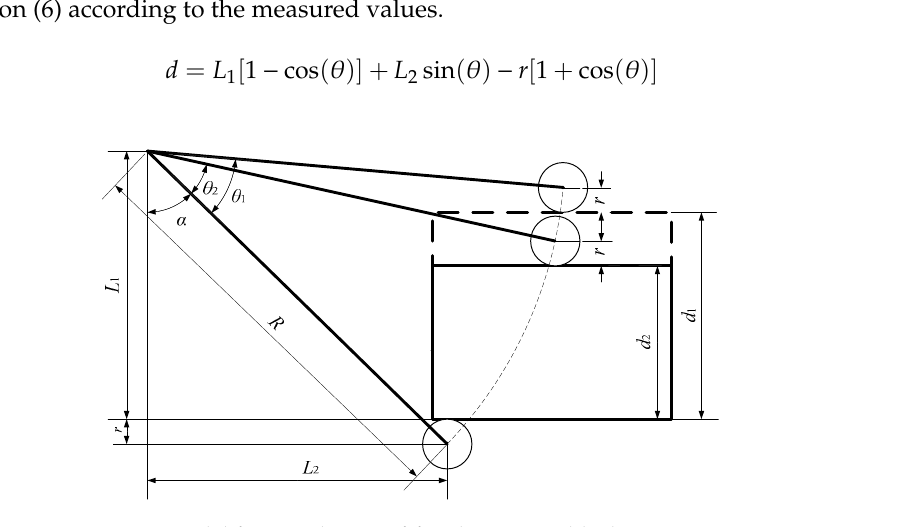
Figure 10. Model for one-degree-of-freedom gauge block measurement. Table 6. Experimental results for standard gauge block